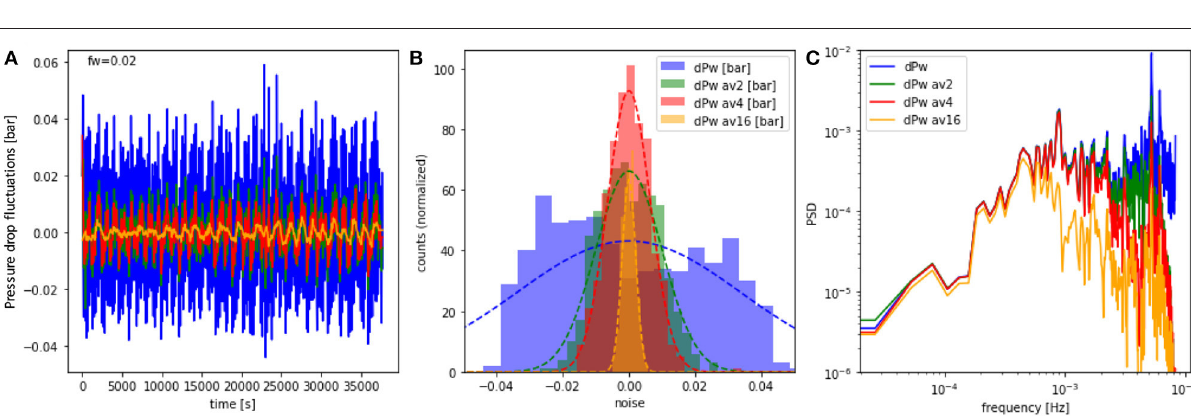
FIGURE 4 | Pressure fluctuations for f w = 0.02 from Figure 2E , and rolling-averages over a window of 2, 4, and 16 data points (A) . While the histogram for the original data (blue) set is bi-modal and clearly distinct from a Gaussian (dotted line), the histograms of the averages become increasingly symmetric and can be fitted very well with Gaussians (B) . The Fourier spectrum (C) shows that smaller frequencies remain unaffected up to the frequency associated with the timer period of the averaging